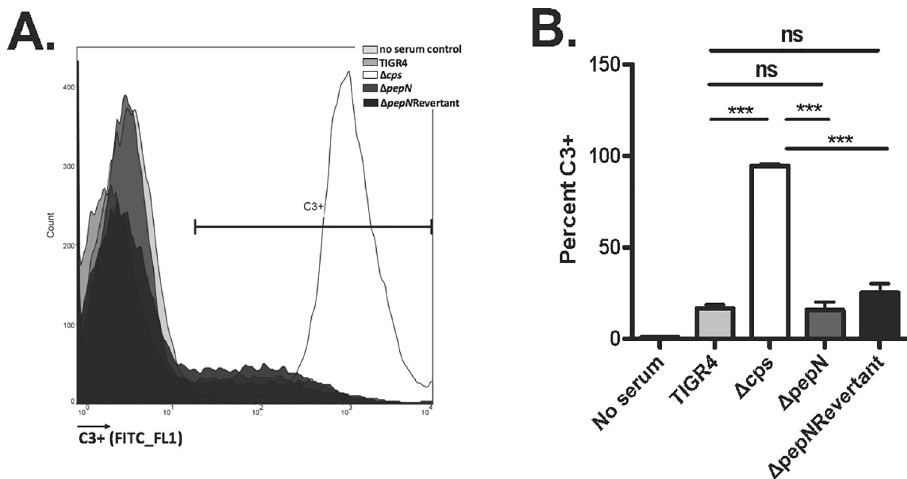
Fig 7. Mutants lacking PepN demonstrate the same C3 deposition phenotype as wild-type TIGR4. Spn cells were incubated with infant rabbit serum and stained with a FITC-conjugated anti-C3 antibody. Data are shown as A) a representative histogram plot from 1 experiment representative of 3 independent experiments and B) means ± SD from 3 independent experiments. ��� , P < 0.001; ns = no significant difference. P values were calculated using one-way